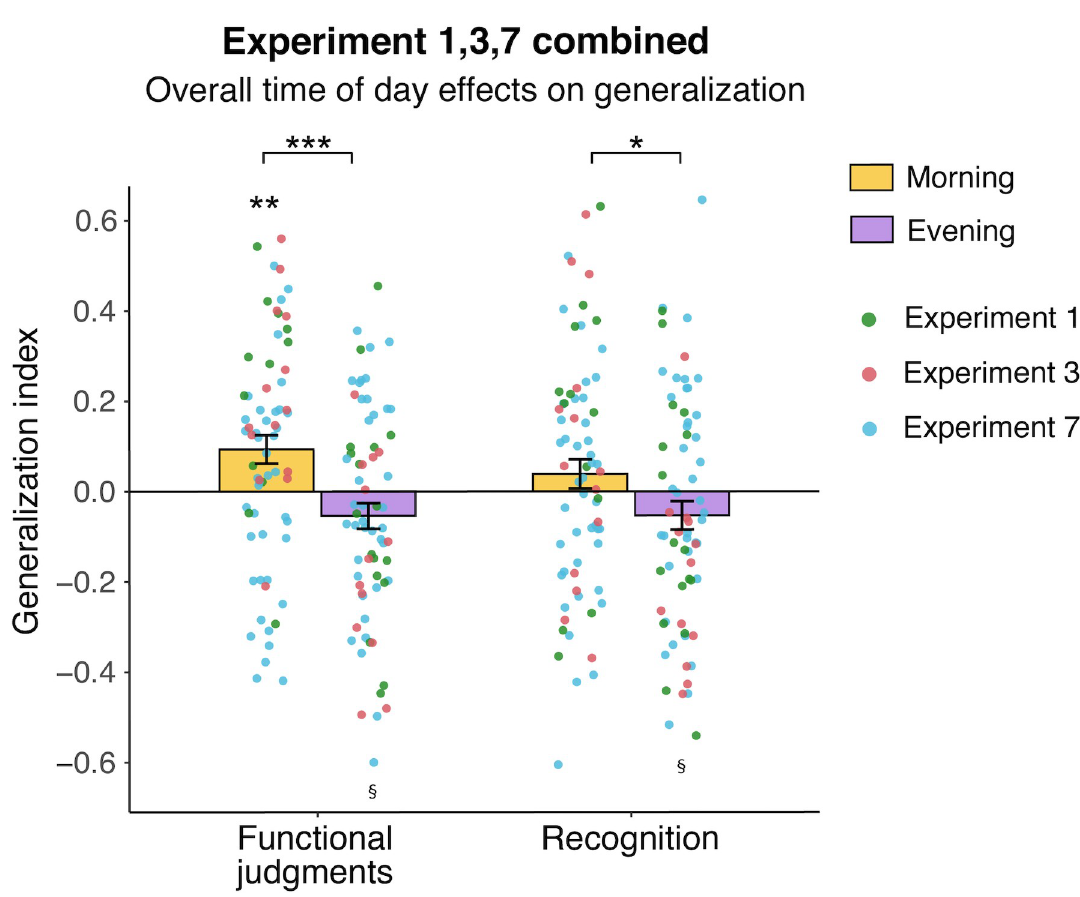
Fig 6. Overall time of day effects on generalization in experiments with the original paradigm (Experiment 1 Test 1, Experiment 3 Test 1, Experiment 7). Colored dots reflect individual participants from each experiment. ��� p < .001, �� p < .01, � p < .05, § p <